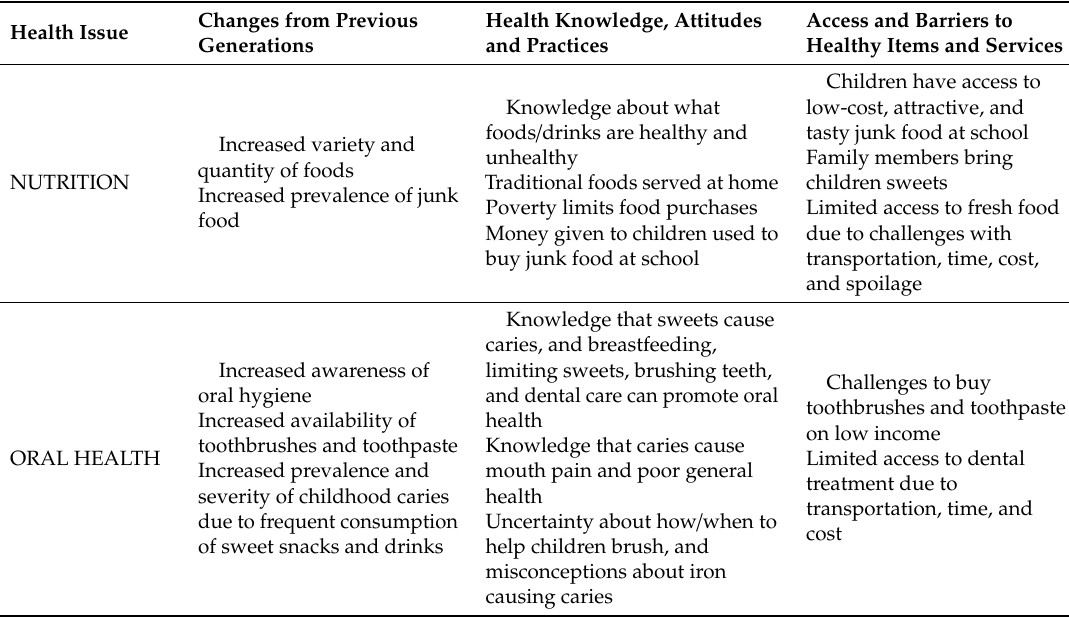
Table 2. Summary of major themes and